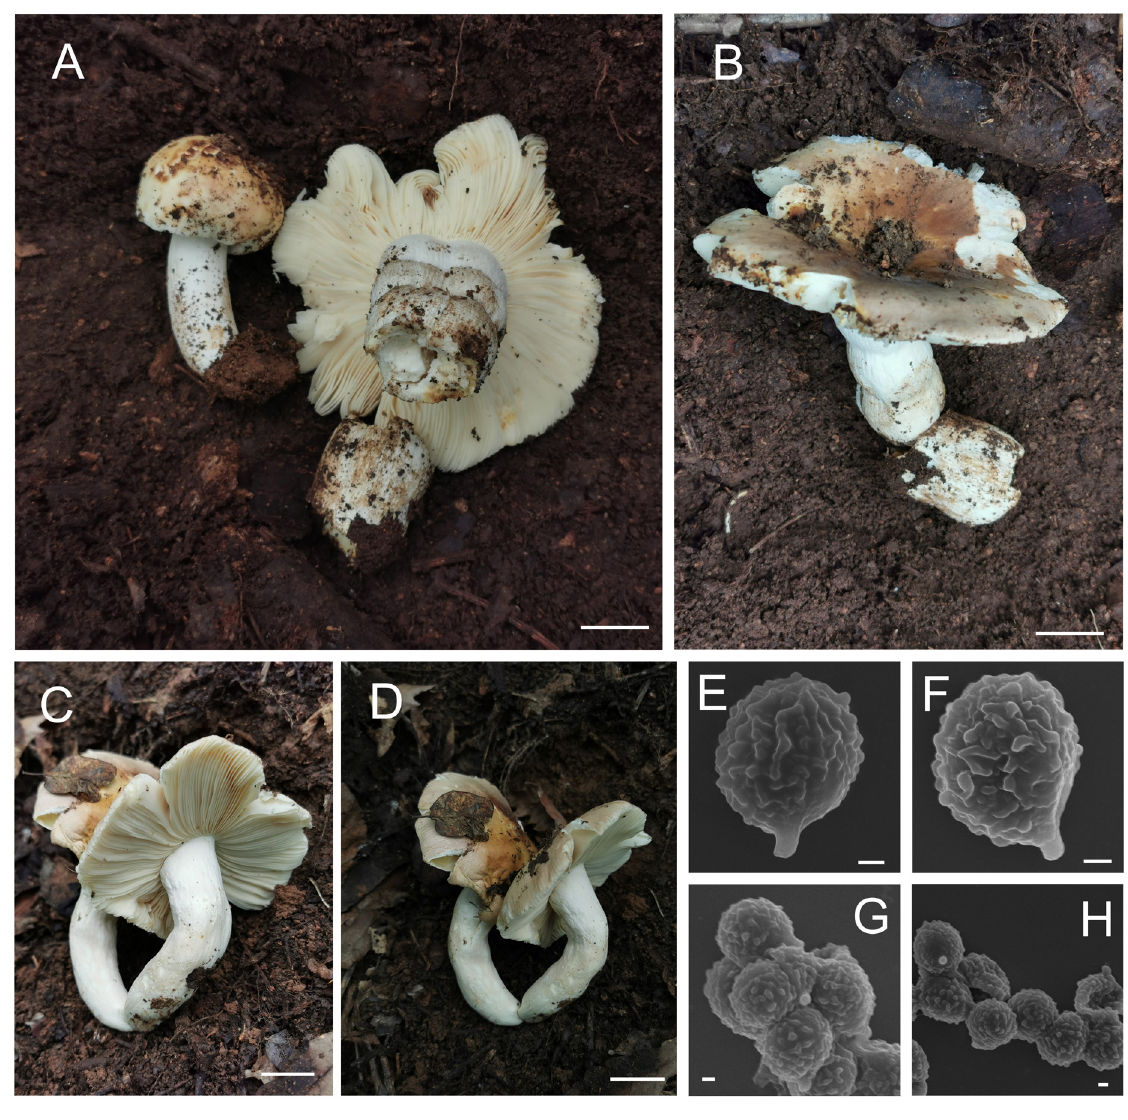
Fig. 3. Basidiomata and basidiospores of Russula pseudopunicea C.L.Hou, G.Q.Cheng & H.Zhou sp. nov. A–D . Basidiomata (A–B = BJTC ZH1392, holotype; C–D = BJTC ZH1389). E–H . SEM micrograph of basidiospores (BJTC ZH1392, holotype). Scale bars: A–D = 10 mm, E–H = 1